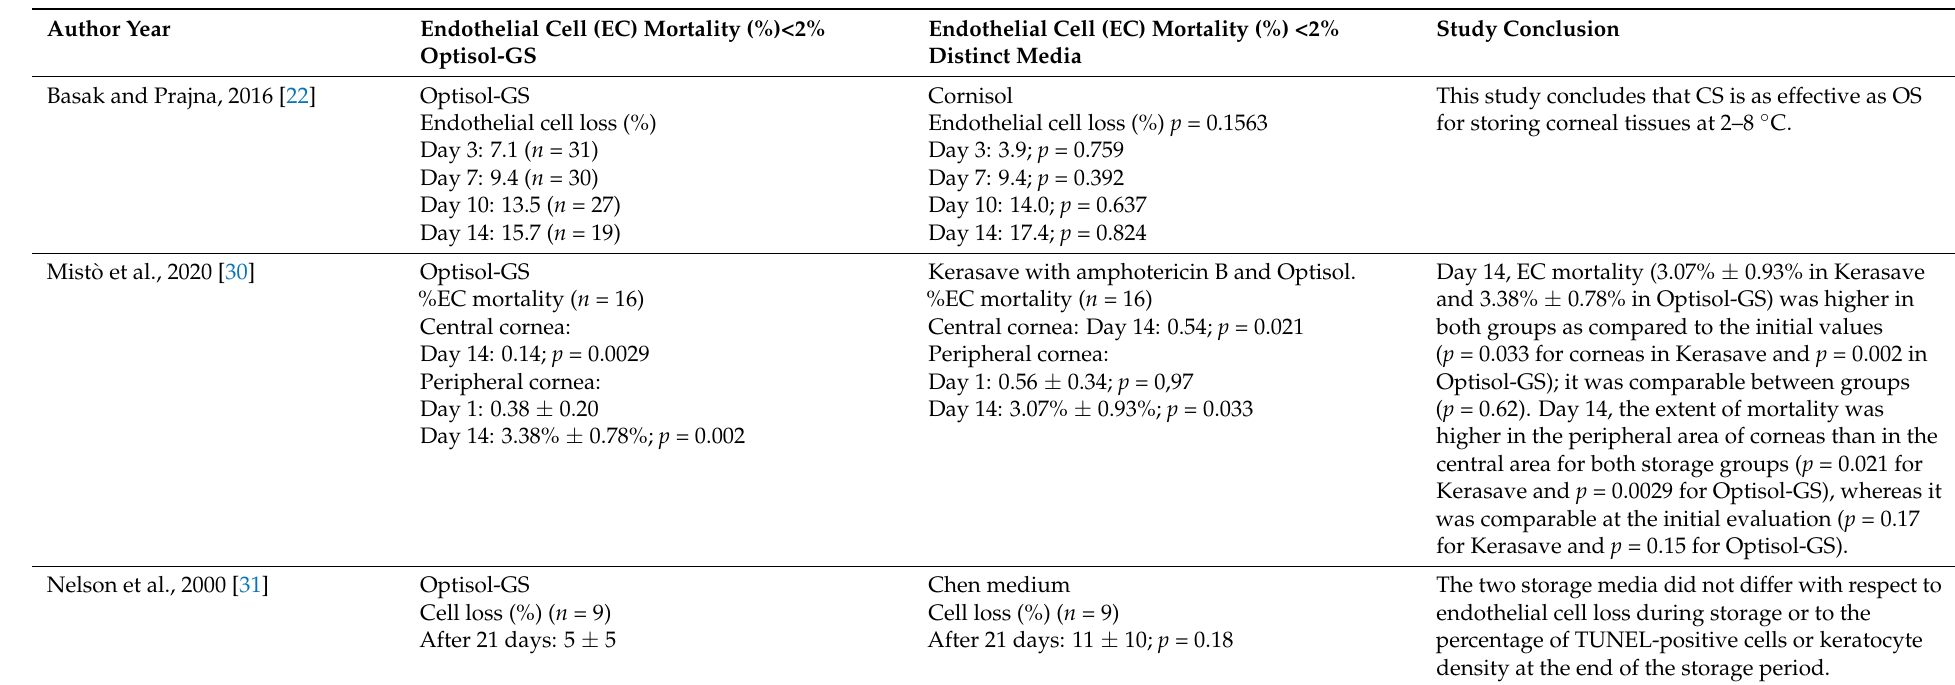
Table 9. Endothelial cell (EC) mortality or